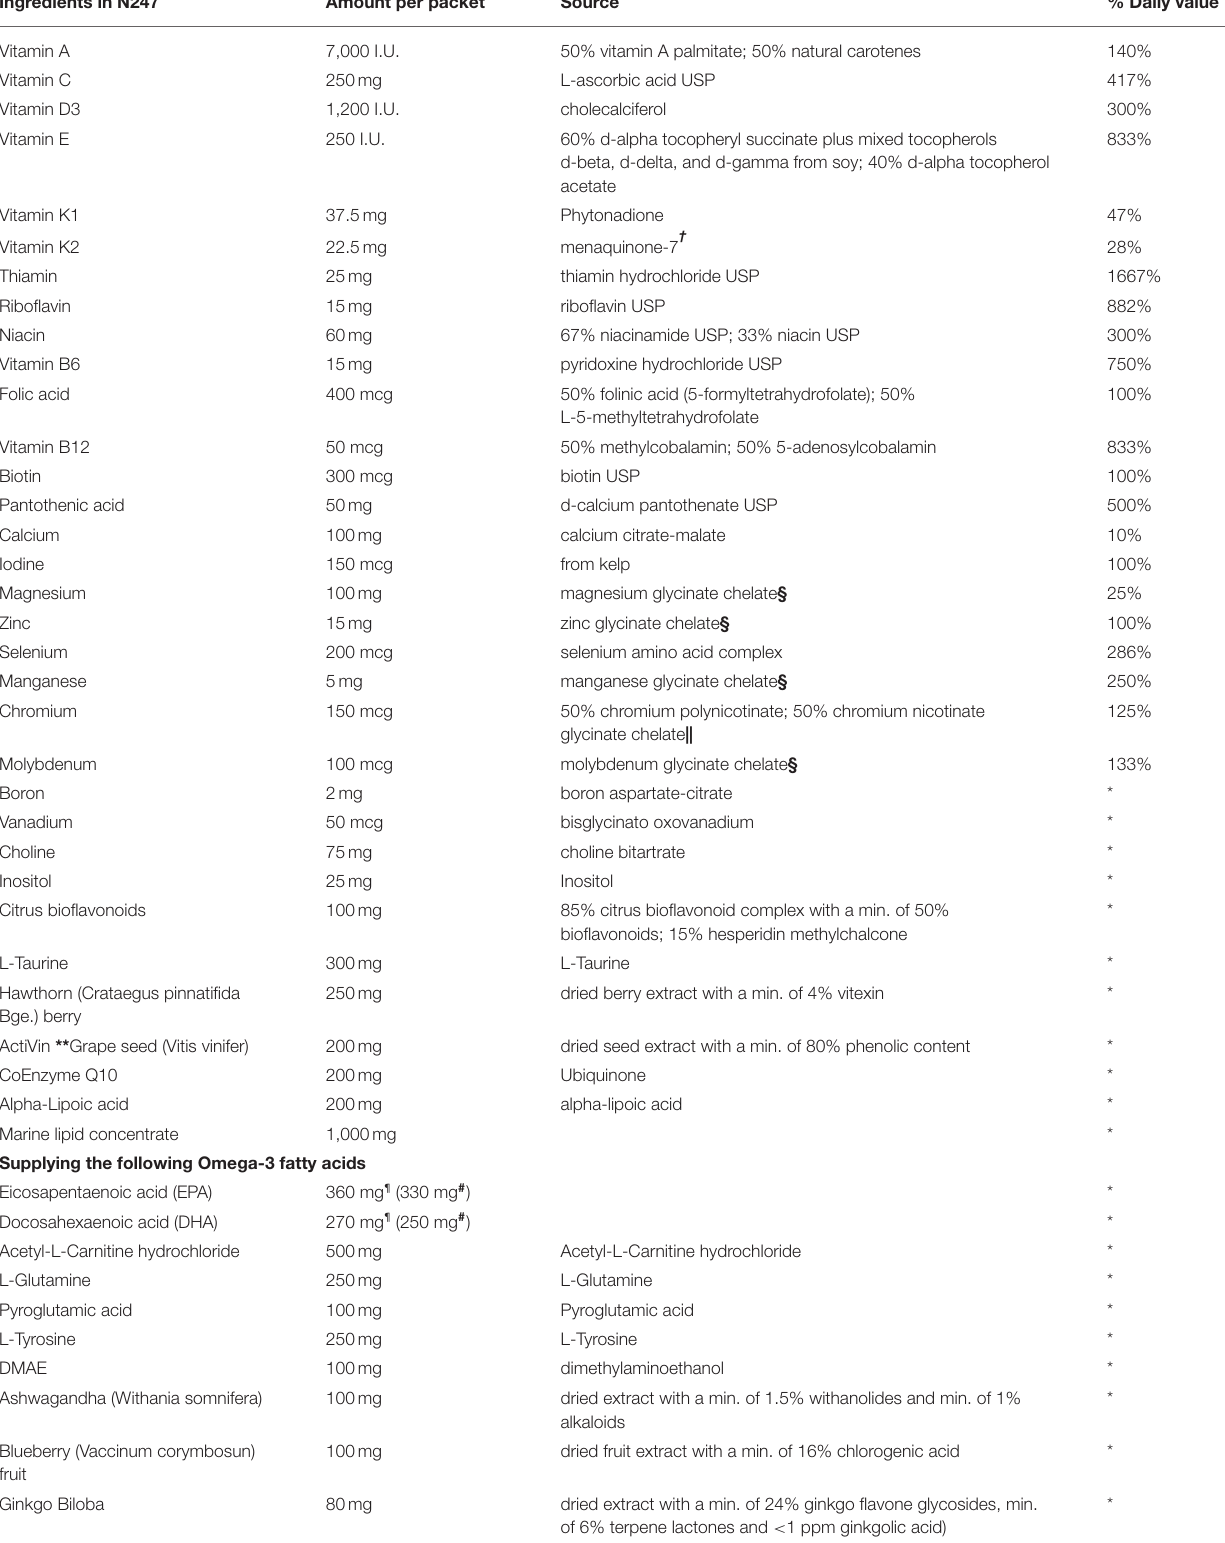
TABLE 1 | Ingredient list, dosage, and special forms of N247. Ingredients in